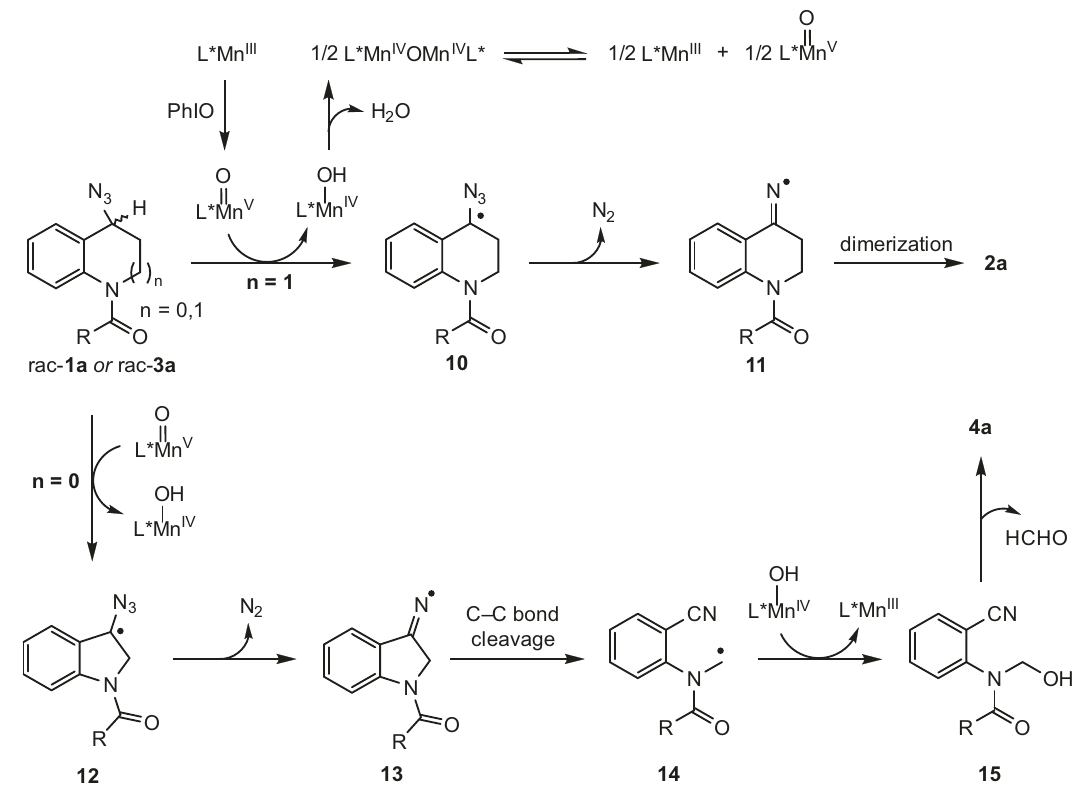
Fig. 6 Proposed reaction mechanism. The possible reaction pathway based on our studies and the previous literatures.